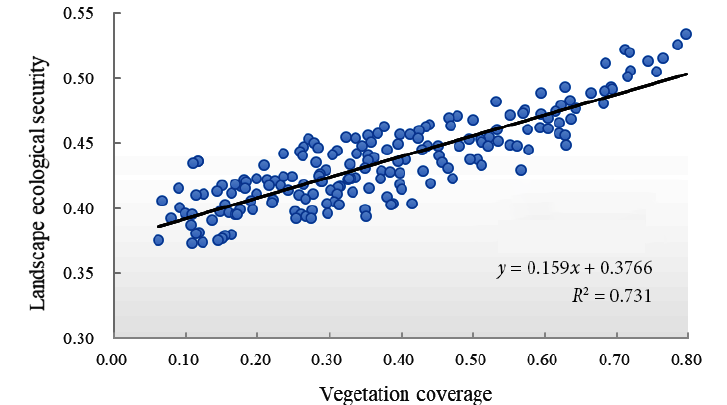
Figure 7. The correlation between landscape ecological security and vegetation coverage in Zhong